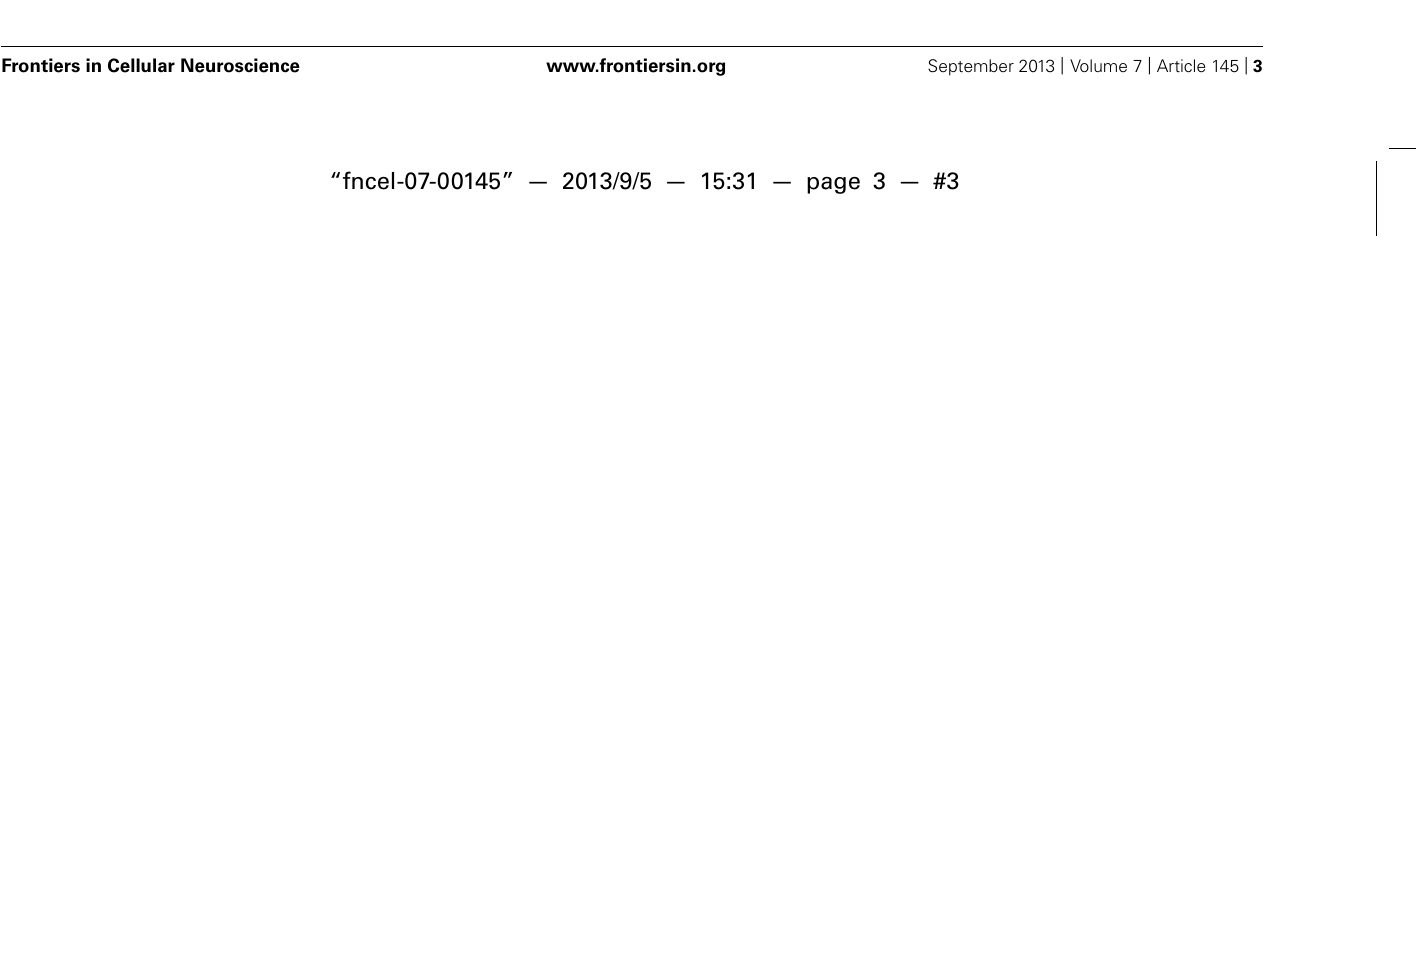
FIGURE 1 | Schematic drawing representing the impact of classical (depicted in red) and alternative (depicted in blue) activation of micro- glia on adult-born neurons (depicted in green) in the hippocampus . In response to changes in the microenvironment microglia can undergo to a potentially neurotoxic “classical activation” (characterized by the release of proinflammatory factors) or a potentially neuroprotective “alternative activation” (characterized by the release of anti-inflamatory cytokines). Polarization toward classical activation can be induced experimentally by exposure to pro-inflammatory cytokines such as